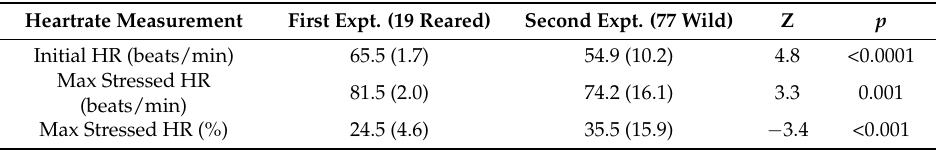
Table 1. Magnitude of heartrate reactions prior to and during restraint stress in O. disjunctus from both experiments. In experiment 1, we used adults that had been reared in our lab from young larvae. In experiment 2 we used adults collected in the wild. p values denote significant differences between experiments based on Mann-Whitney U tests.